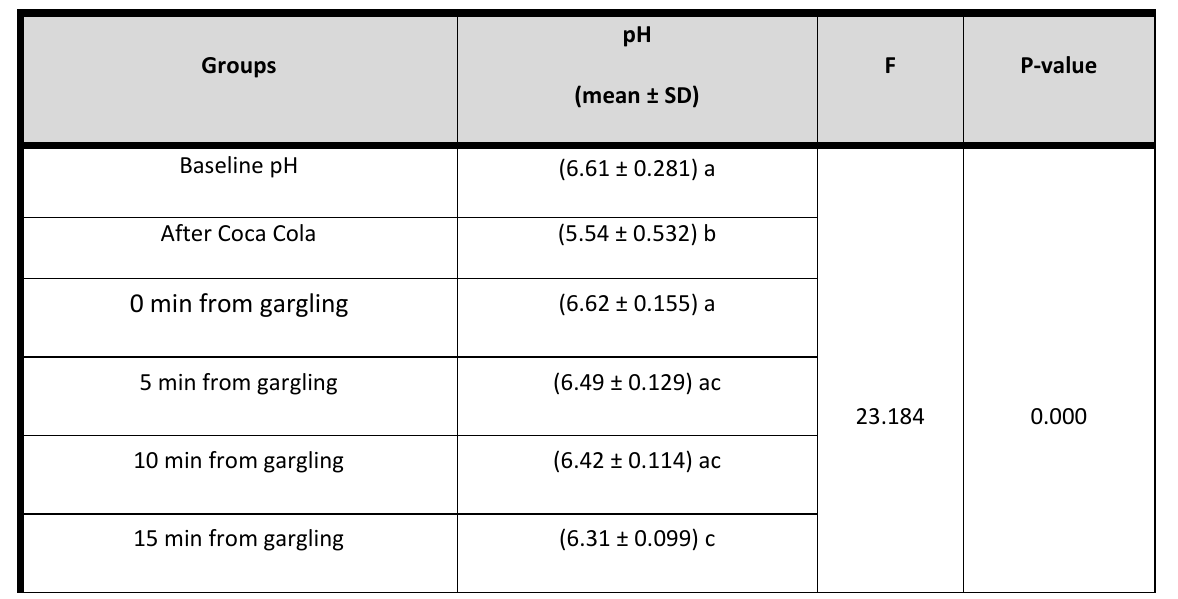
Table 4. One way ANOVA of salivary pH after tap water mouthwash